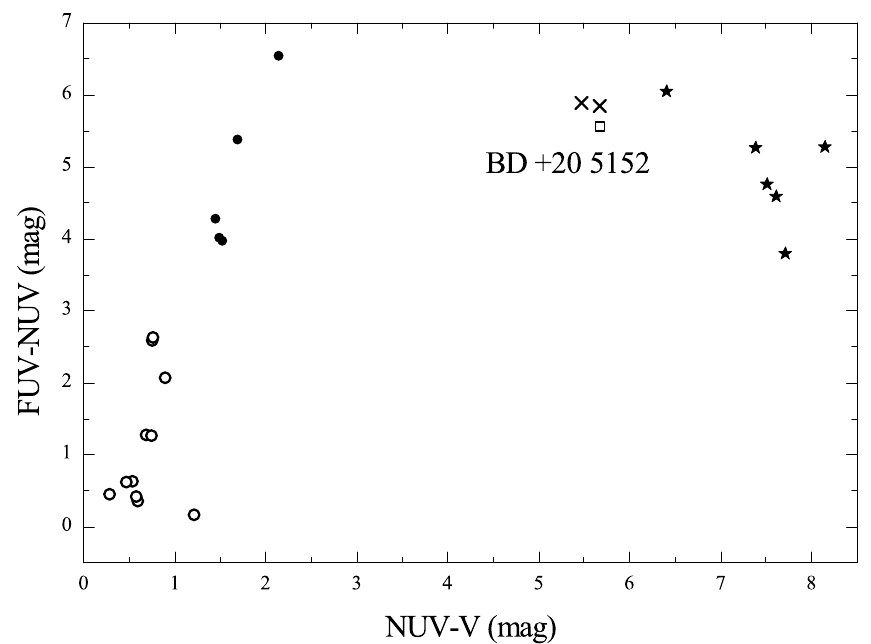
Fig. 3. The GALEX FUV{NUV vs. NUV{V UBV diagram. Standard G2–G8 stars are plotted as asterisks. Two Hyades cluster dwarfs are denoted by crosses. White dwarfs with T eff = 10500–13500 K are marked by open circles and those with T eff = 7300–8500 K by dots. Hyades cluster dwarfs, HD 26736 ( B – V = 0.66) and HD 26756 ( B – V = 0.70) from Smith et al. (1991). For these two stars a high level of chromospheric activity has been indicated by a low value of index I (Mg II) derived from the IUE